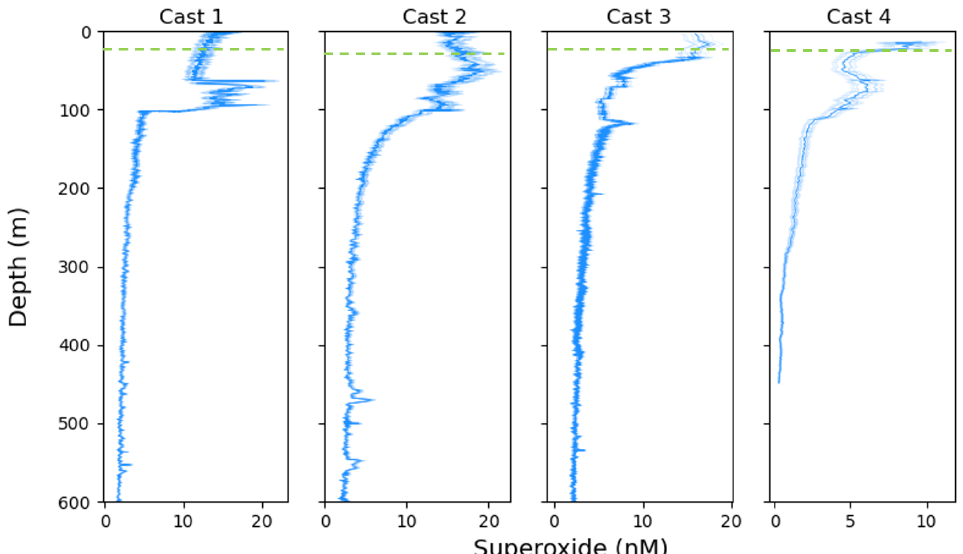
Figure 9. O – 2 concentrations (nM) as a function of depth collected with the SOLARIS during four different CTD casts off of western California. The light blue lines highlight the uncertainty range based on a Monte Carlo simulation (±1 S.D) of all calibration factors obtained along the cast. The green dashed line depicts the depth of the surface mixed